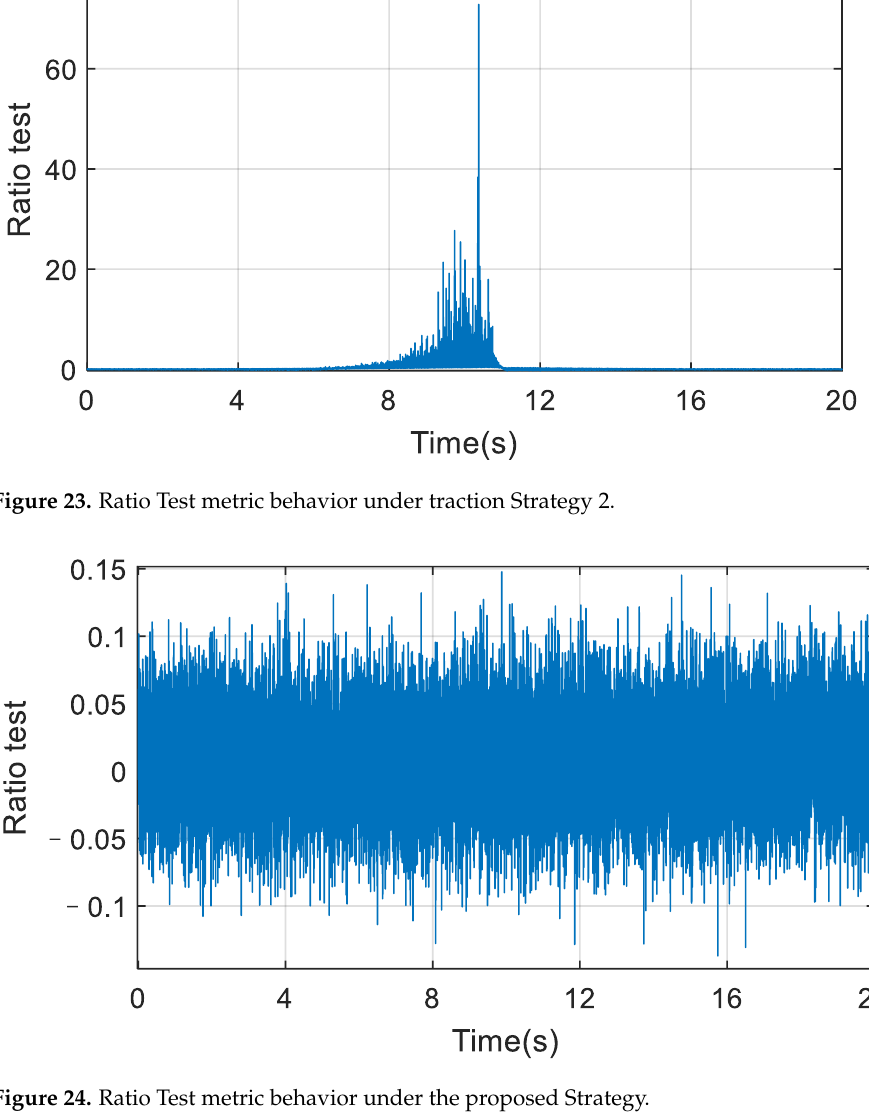
Figure 24. Ratio Test metric behavior under the proposed Strategy.